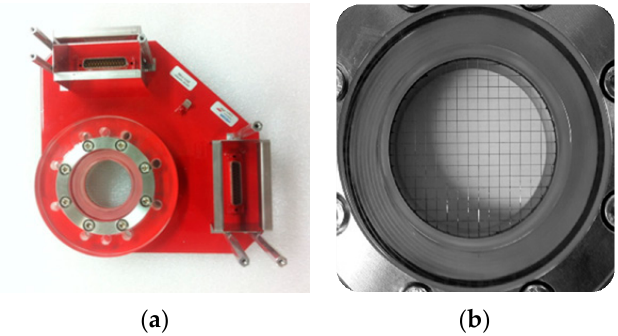
Figure 9. Wire-mesh sensor manufactured by HZDR Inc. (Dresden, Germany) for validation of the measured void fraction. ( a ) Photograph of the wire-mesh sensor used in this study. ( b ) Transmitter and